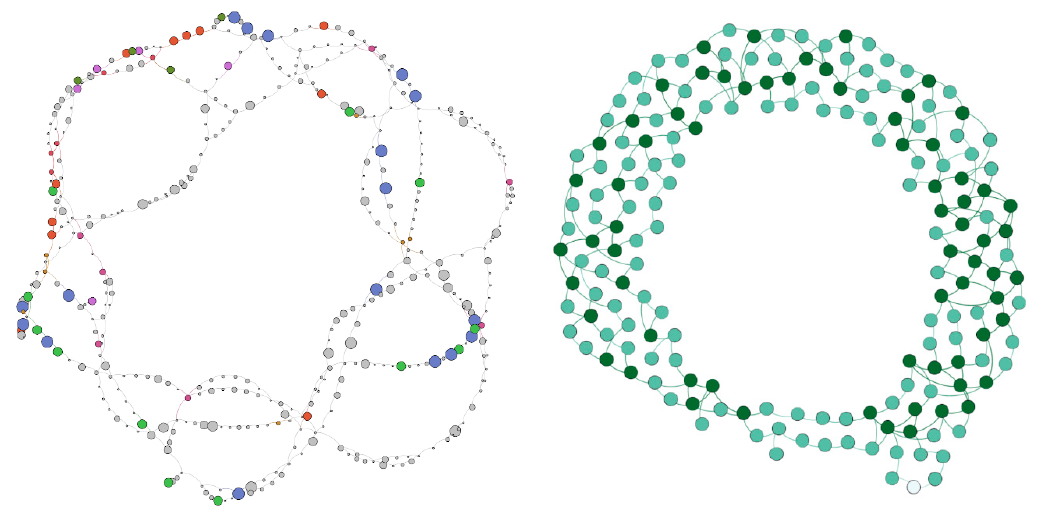
Figure 4. (Left) HIV-1 reference genome graphs generated with SWIft Genomes in a Graph (SWIGG) with annotated k -mers / nodes. Number of input sequences ( n ) = 167. Node color corresponds to taxonomic distribution of k -mer. Size of nodes is proportional to occurrence of taxonomic category. (Right) HIV-1 subtypes A–J ( n = 39), k -mer size = 41, threshold ≥ 2. Note that both example graphs are circular, which may represent the fact that common nodes occur within long terminal repeats (LTRs).